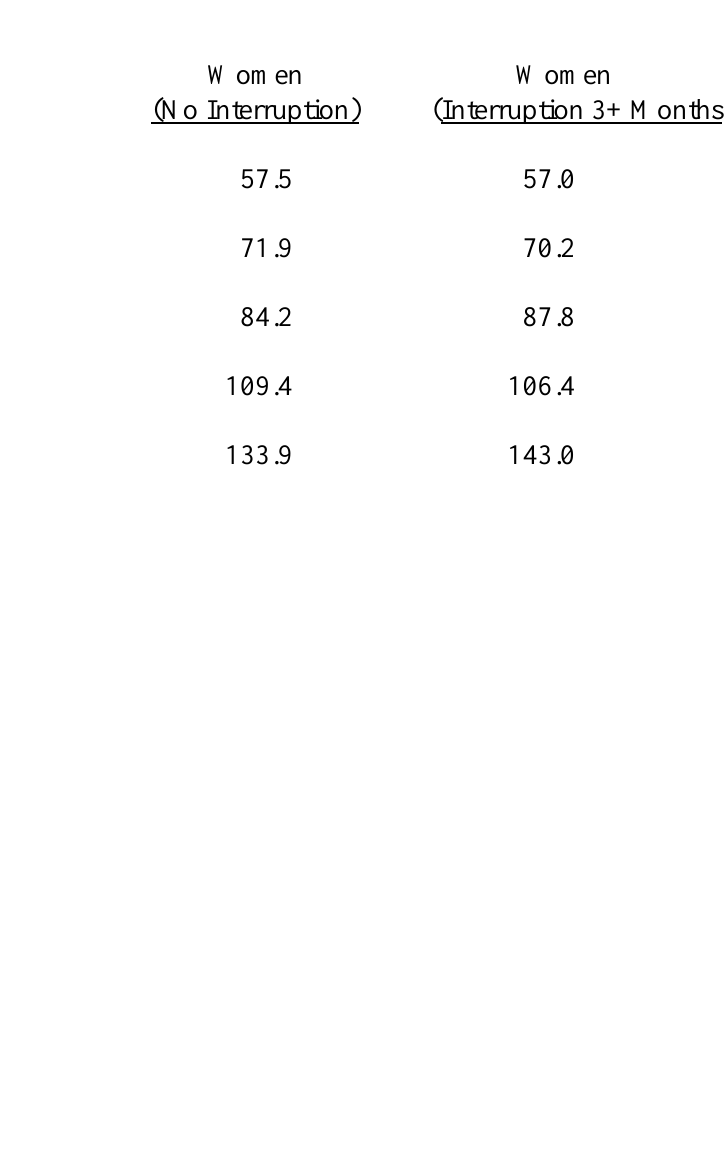
Table 9. Median Salary by Career Interruption (Full-time only)